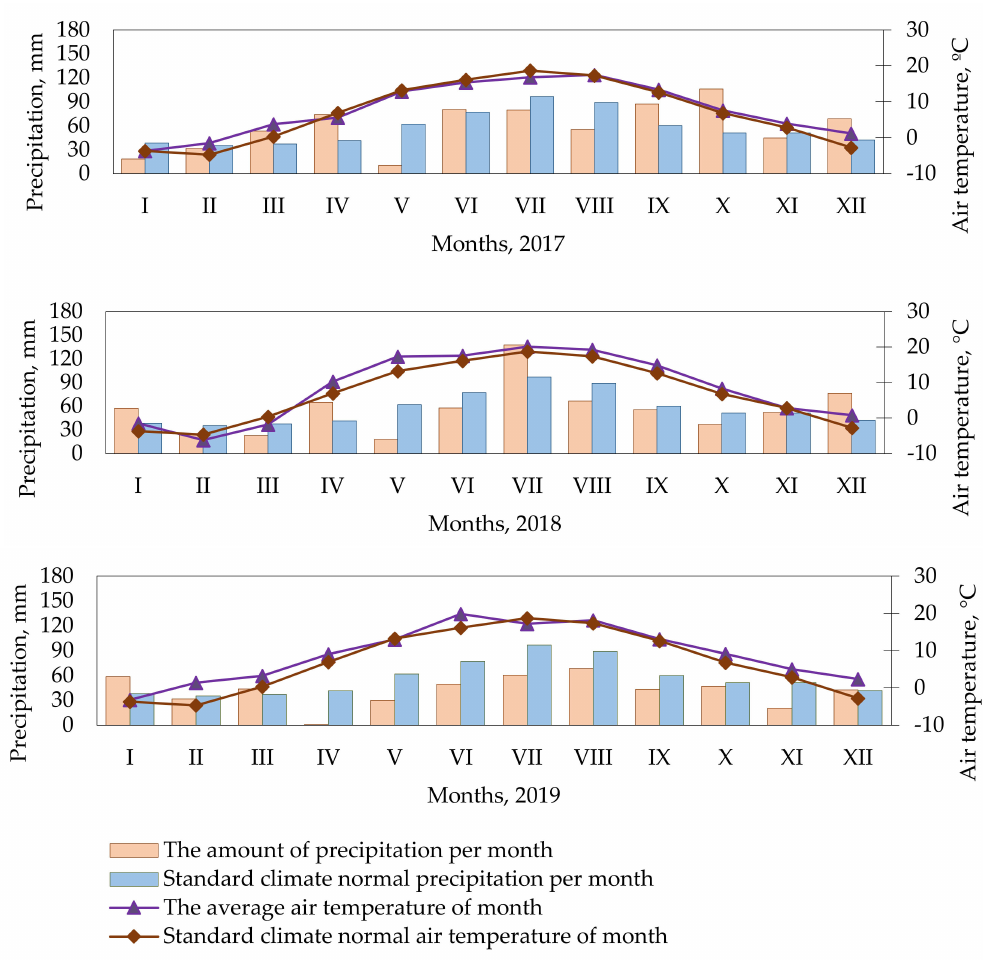
Figure 8. Meteorological conditions during the experimental period, Kaunas Meteorological Station, 2017–2019. Note. Long-term average is the data for 40 years